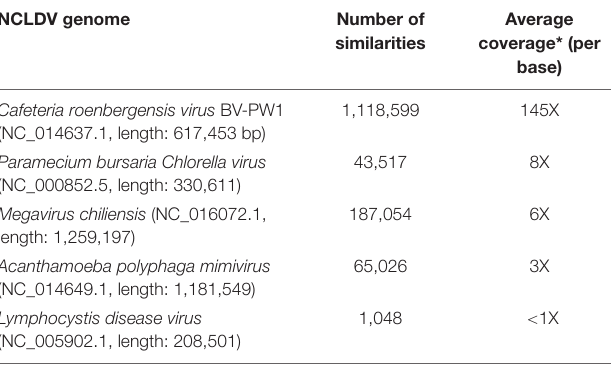
TABLE 1 | Results of MegaHit contig recruitments to